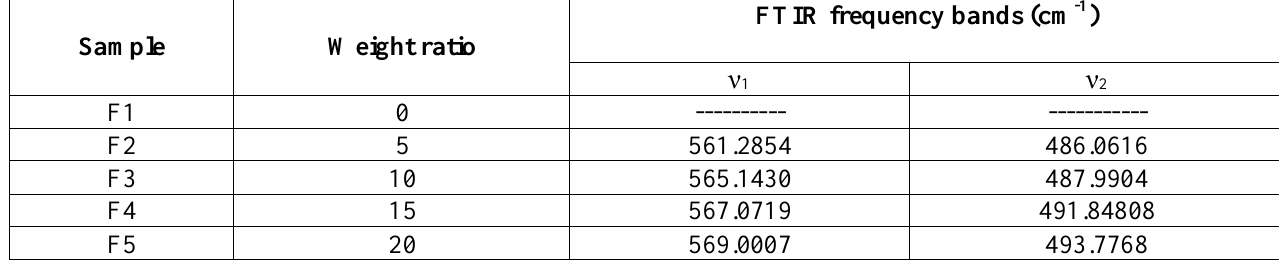
Figure 3: FTIR of the prepared specimens. Table 3: FT-IR spectral bands of prepared